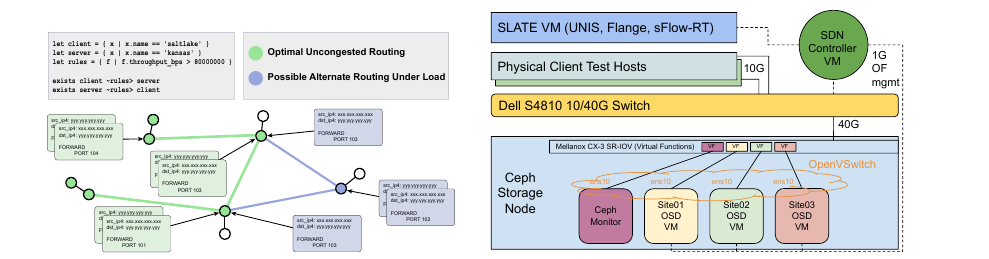
Figure 3. Programs written in the Flange DSL and compiled solutions.